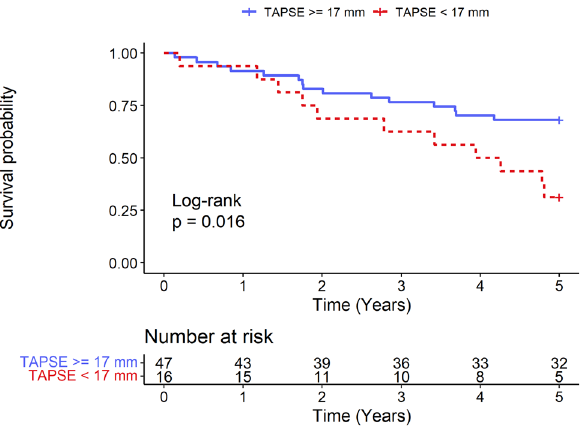
Figure 2. Title: Long-term survival following CRT-D according to RV function. Kaplan–Meier survival estimates according to baseline RV dysfunction defined as TAPSE under 17 mm. Patients with baseline TAPSE under 17 mm had a significantly lower probability of survival. CRT-D: cardiac resynchronization therapy- defibrillator; RV: right